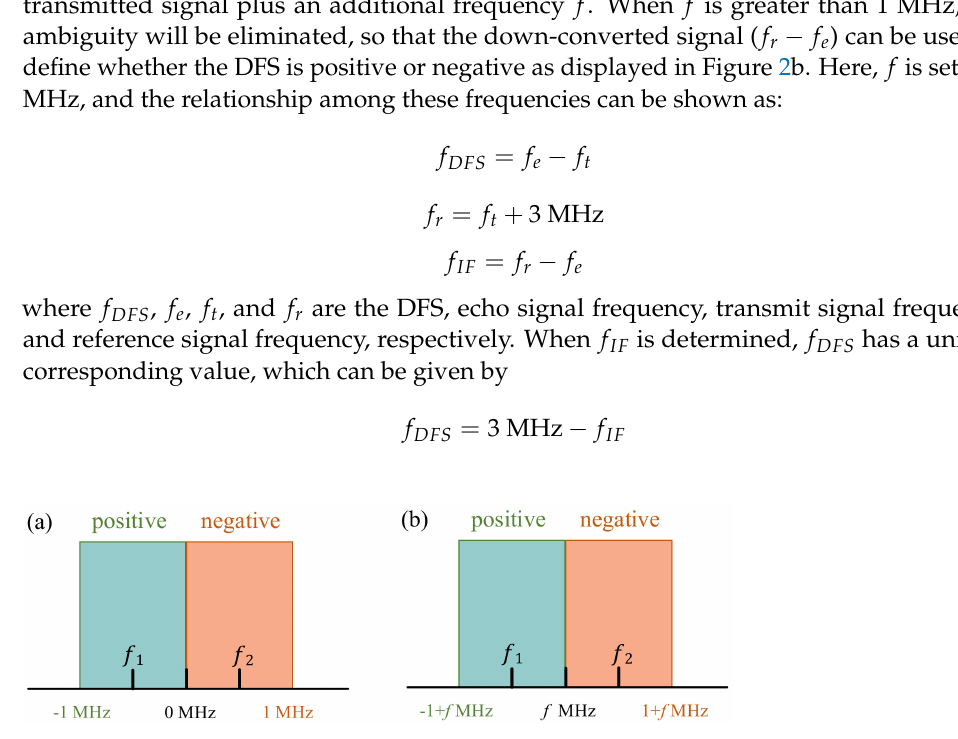
Figure 2. Down-converted microwave signal ( a ) with directional ambiguity; ( b ) without directional ambiguity by adding a